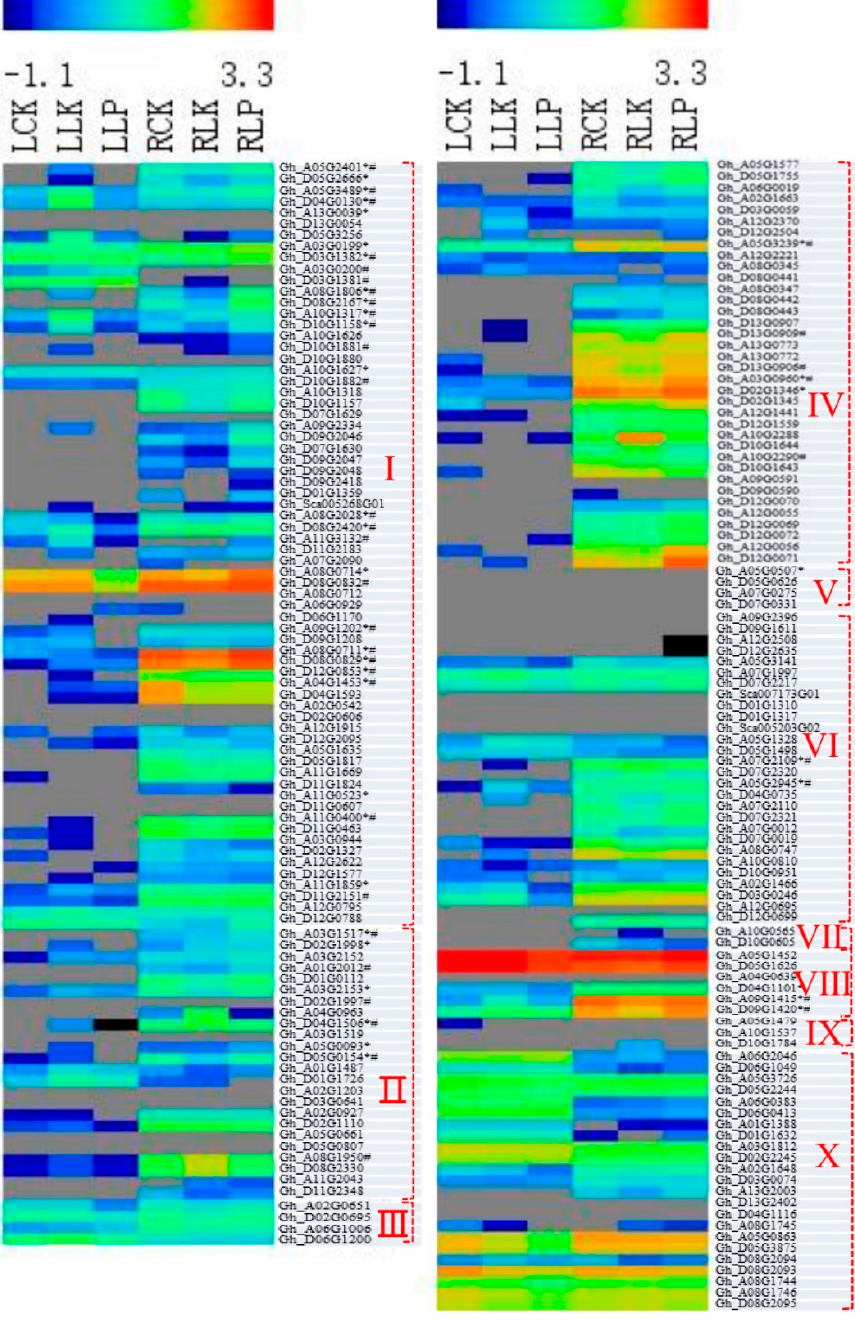
Figure 4. Responses of gene expression in cotton root and leaf to PK deficiency. Values are log 10 FPKM . * the POD protein was detected in the field cotton xylem sap; # the POD protein was detected in the greenhouse cotton.